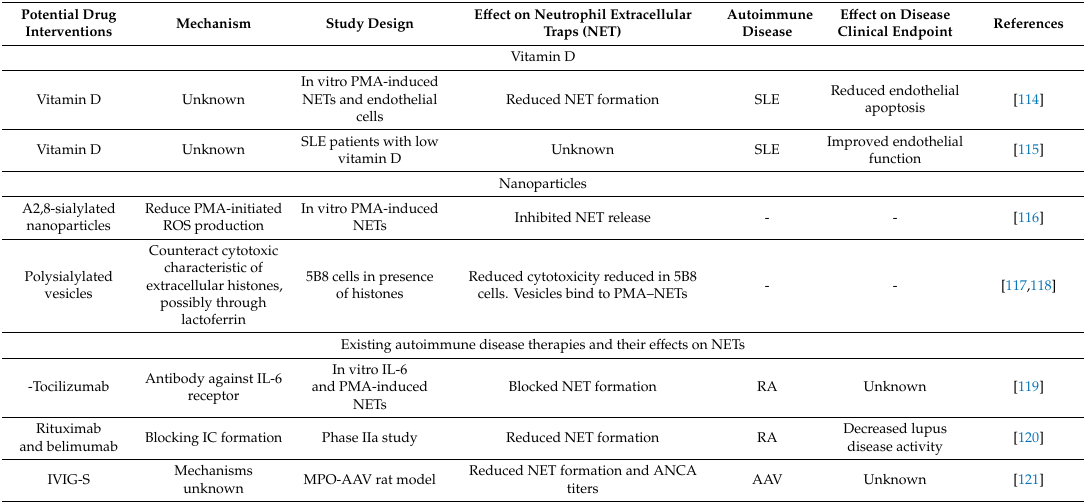
Table 2. Potential drug interventions targeting neutrophil extracellular traps (NETs) in autoimmune diseases (in vitro and in vivo